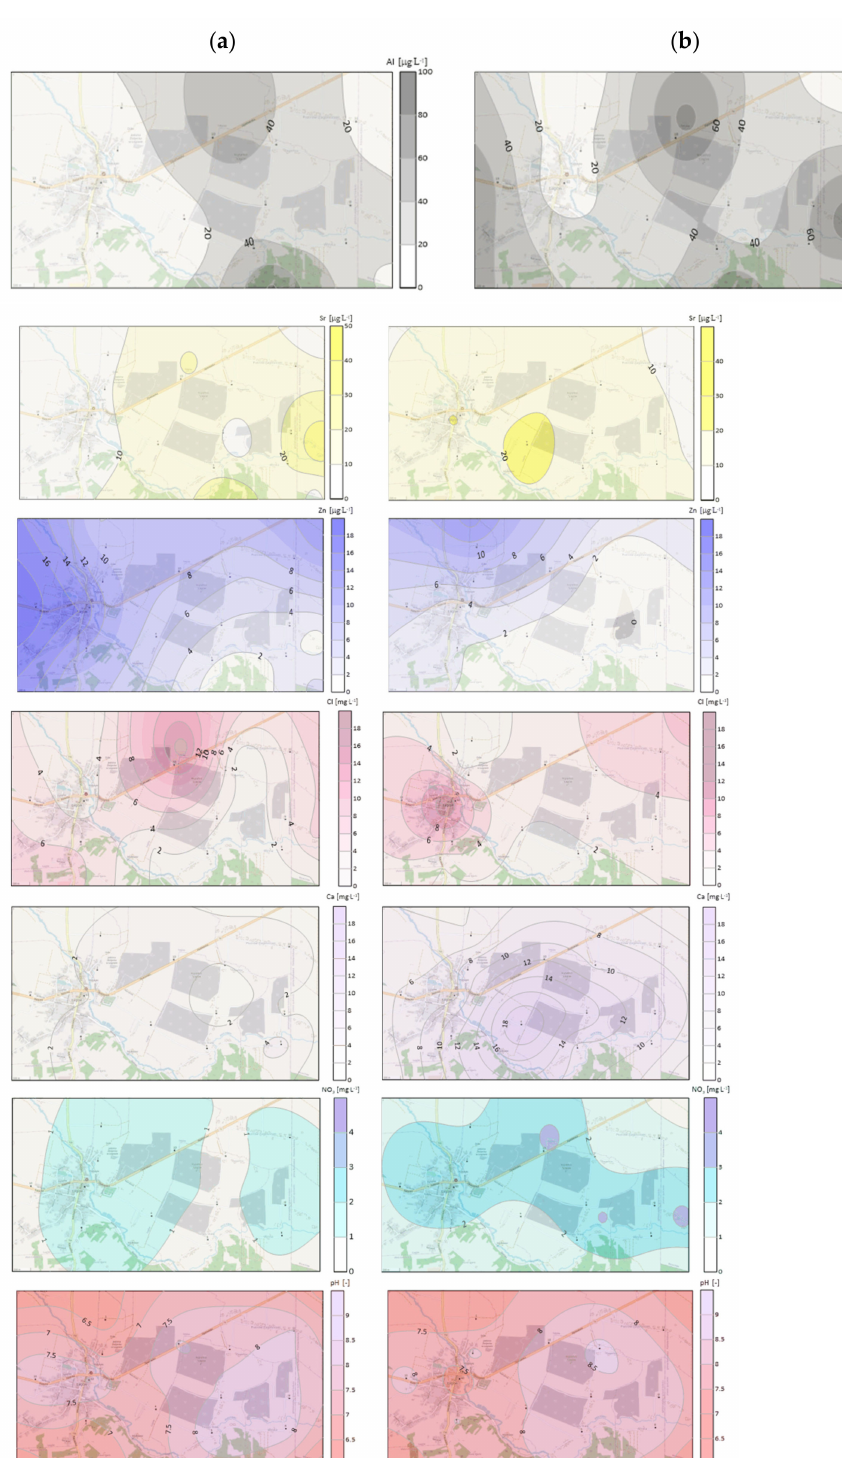
Figure 3. Spatial distribution of selected analytes in the snow cover in the study area: ( a ) first series, left column; ( b ) second series, right